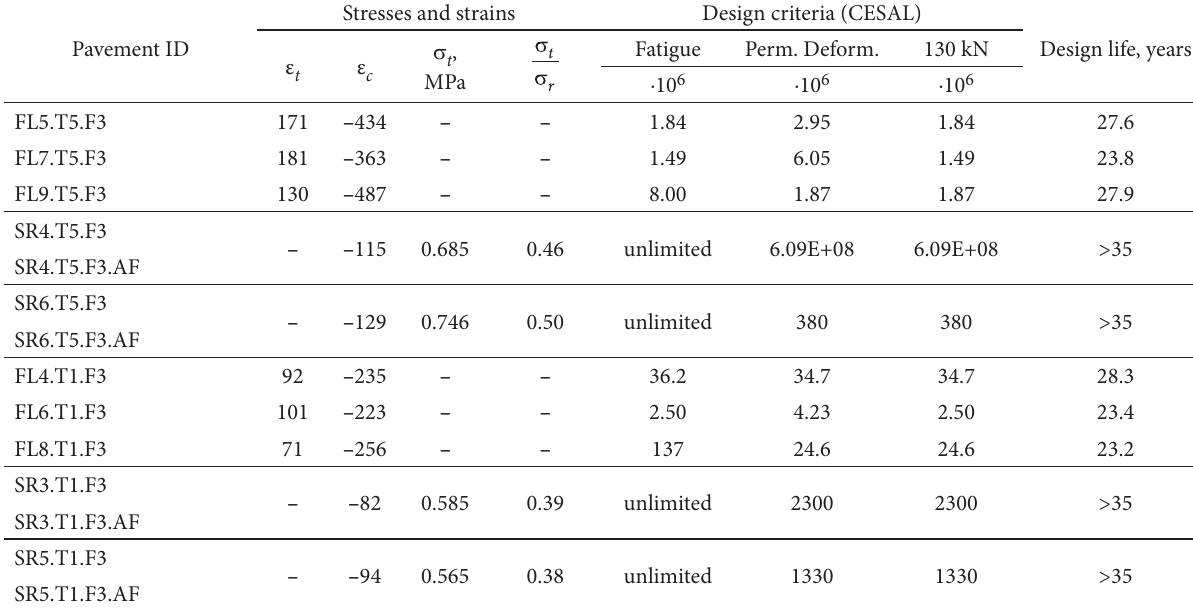
Table 3. Structural design life of pavement structures Stresses and strains Design criteria Pavement ID